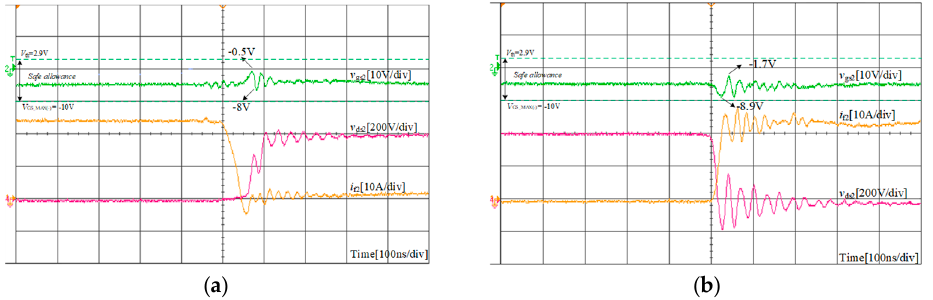
Figure 9. Experimental results with the conventional driver. ( a ) during Q 1 turn − ON transition, and ( b ) during Q 1 turn-OFF transition.